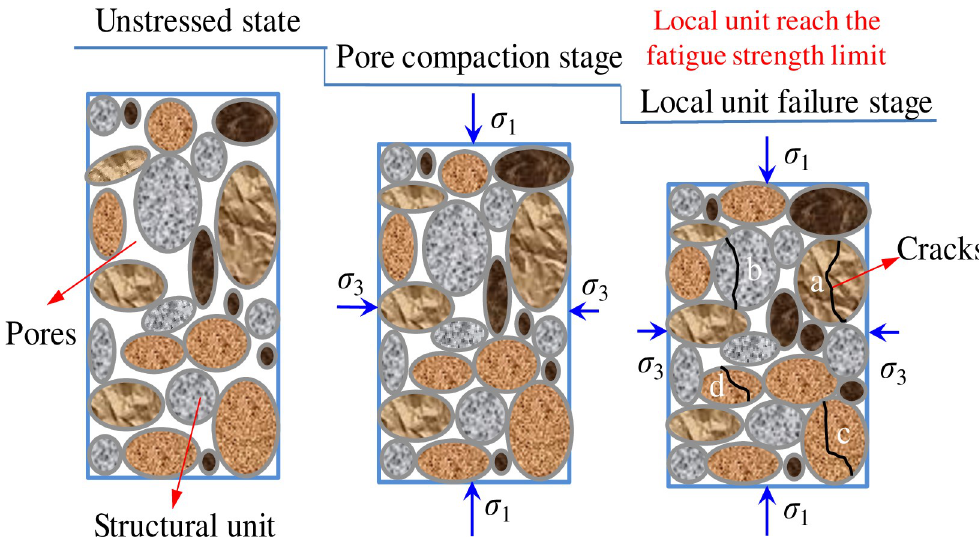
Fig 10. Schematic diagram of deformation and failure of sandstone structural units under external